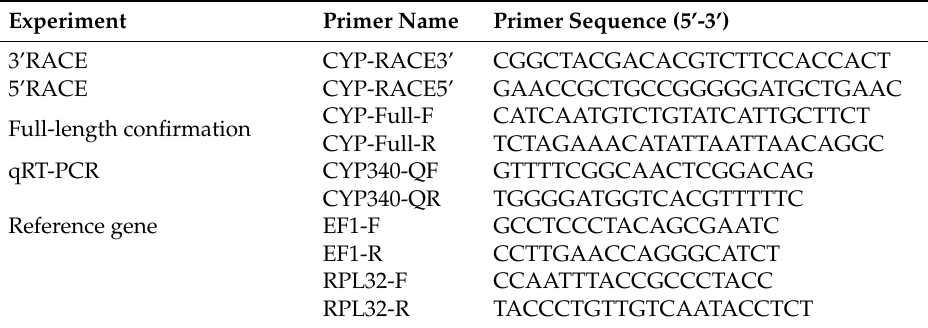
Table 2. Primers used for cloning and expression analysis of CYP340W1